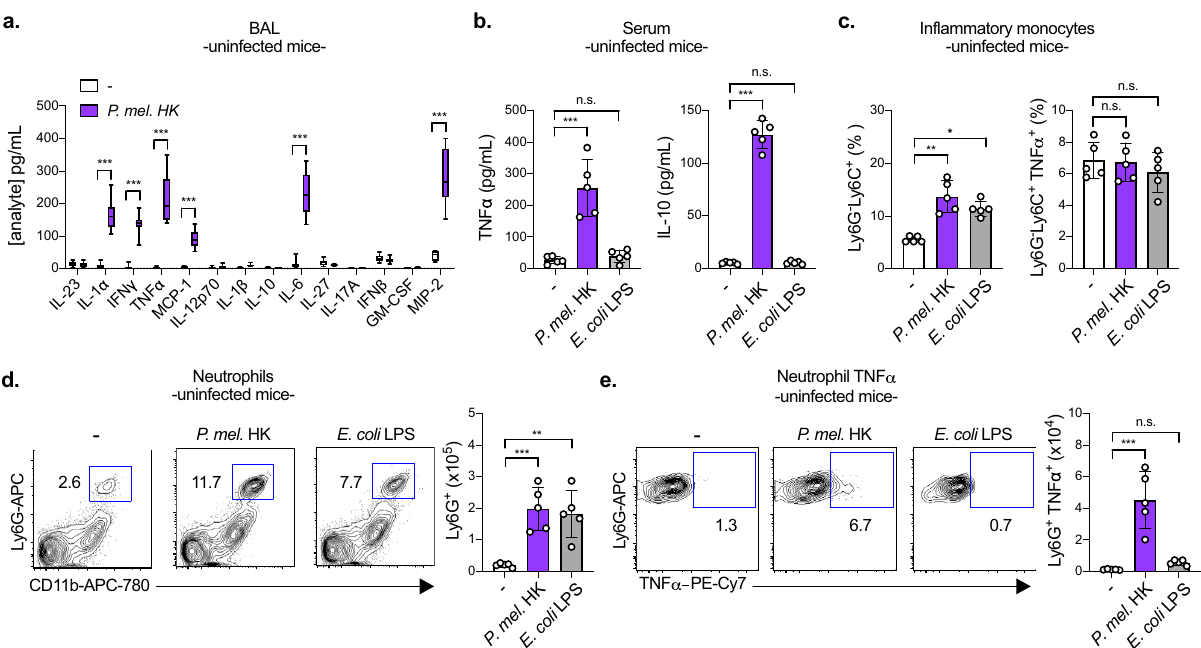
Fig. 2 P. melaninogenica ( P. mel.) induces a pro-in fl ammatory immune response in the lung associated with neutrophil activation in the absence of S. pneumoniae infection. a Quanti fi cation of cytokines and chemokines in lung bronchoalveolar lavage (BAL) following exposure to PBS (-) or P. mel . heat- killed (HK) strain 25845 i.t. for 24 h ( n = 10 mice/group). b Serum cytokines detected in mice exposed to PBS (-), P. mel . HK, or E. coli